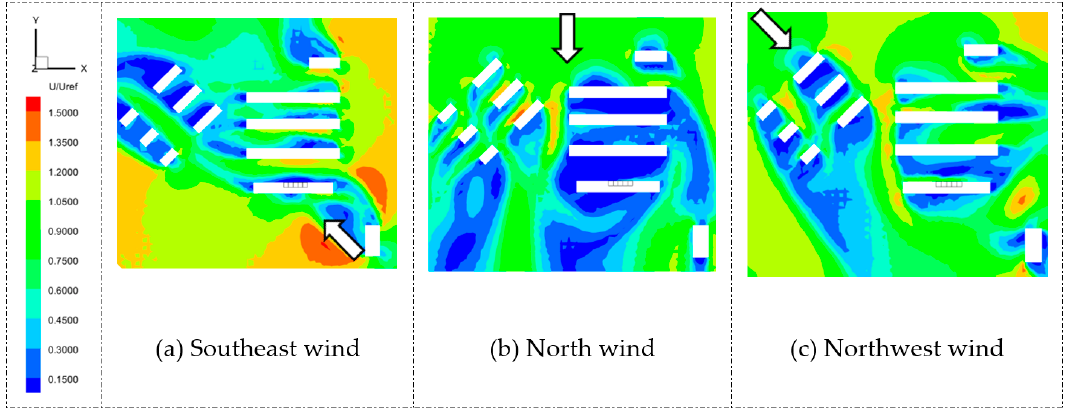
Figure 7. Contours of mean velocity on horizontal planes of Q1 at the height of 0.46 m under three wind directions. Arrows represent three different wind directions.